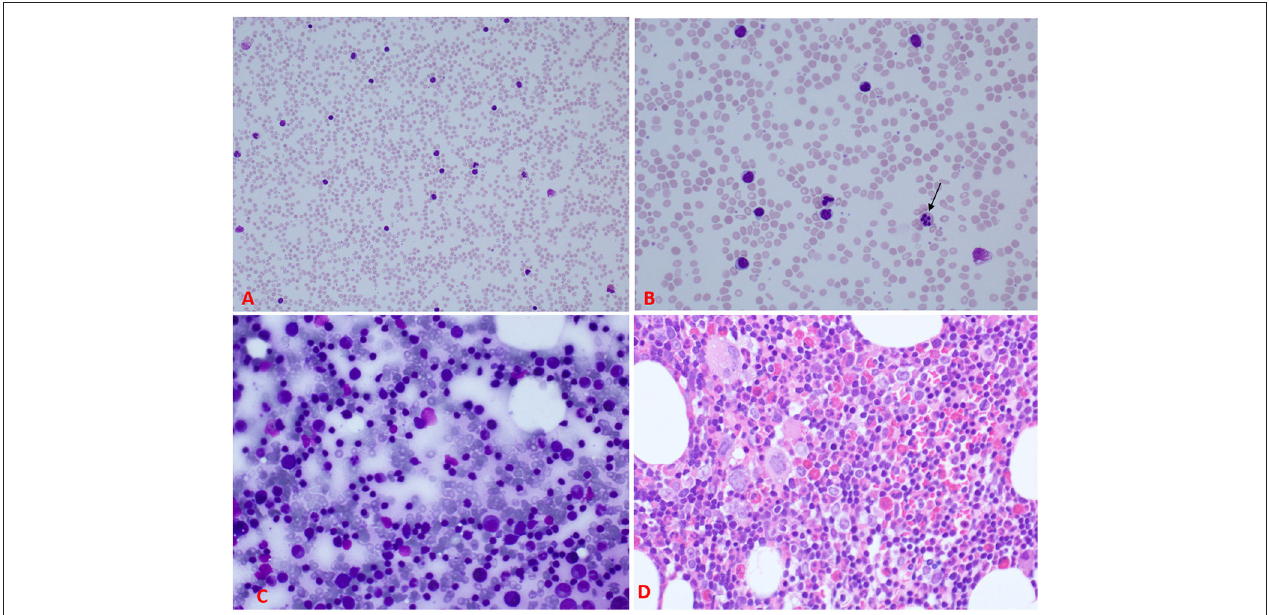
FIGURE 3 | Peripheral blood and bone marrow morphology. (A) A low power view of the peripheral blood smear demonstrating significant leukocytosis. (B) A higher magnification of the smear showing the leukocytosis predominantly lymphocytes mixed with neutrophils; some of the neutrophils reveal abnormal nuclear lobation, like hypersegmentation (arrow). (C) Bone marrow aspirate showing normal maturation of erythroid and myeloid cells and increased lymphocytes with some immaturity suggestive of hematogones. (D) Section from the bone marrow biopsy showing about 70% cellularity (normal for age) of trilineage hematopoiesis with increased eosinophils, lymphocyte aggregates, and interstitial lymphocytes. Megakaryocytes were adequate with normal morphology [For comparison, please see ( 19) for normal peripheral blood and bone marrow smears].